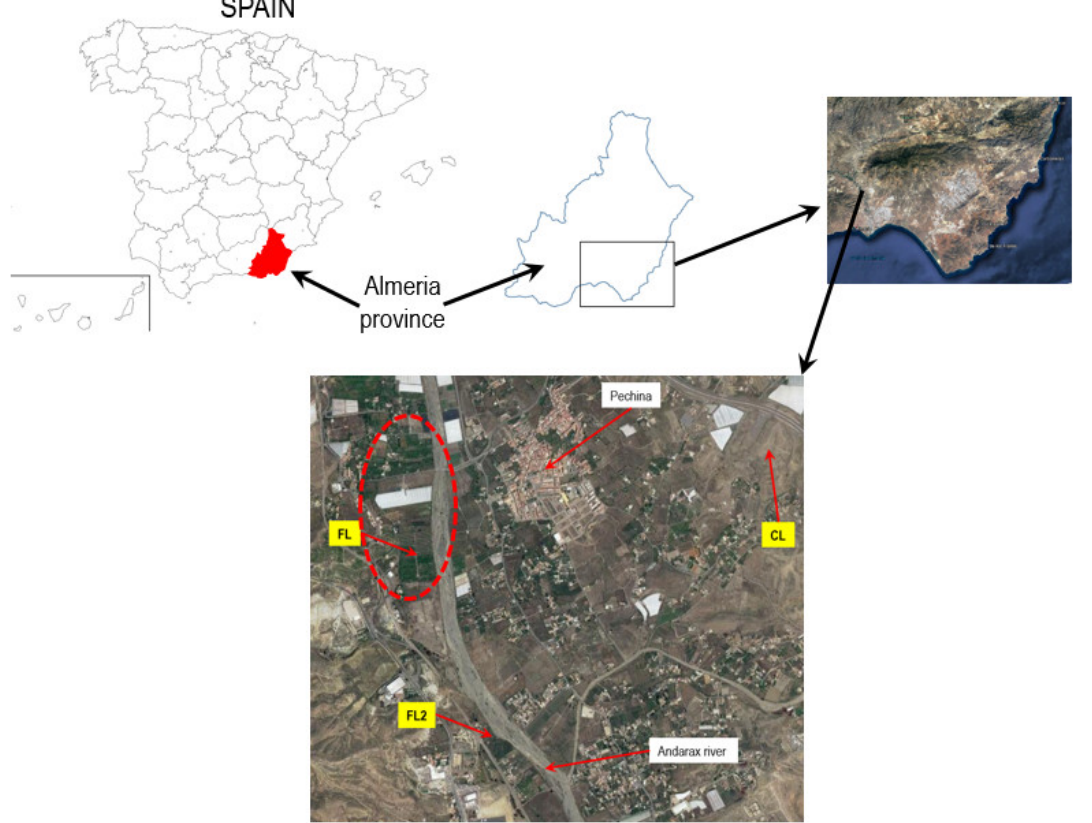
Figure 1. Location of Fluvisols (FL) from the study area. In the surroundings, there are Calcisols (CL) and Fluvisols (FL2) that will show an important wind flow influence.